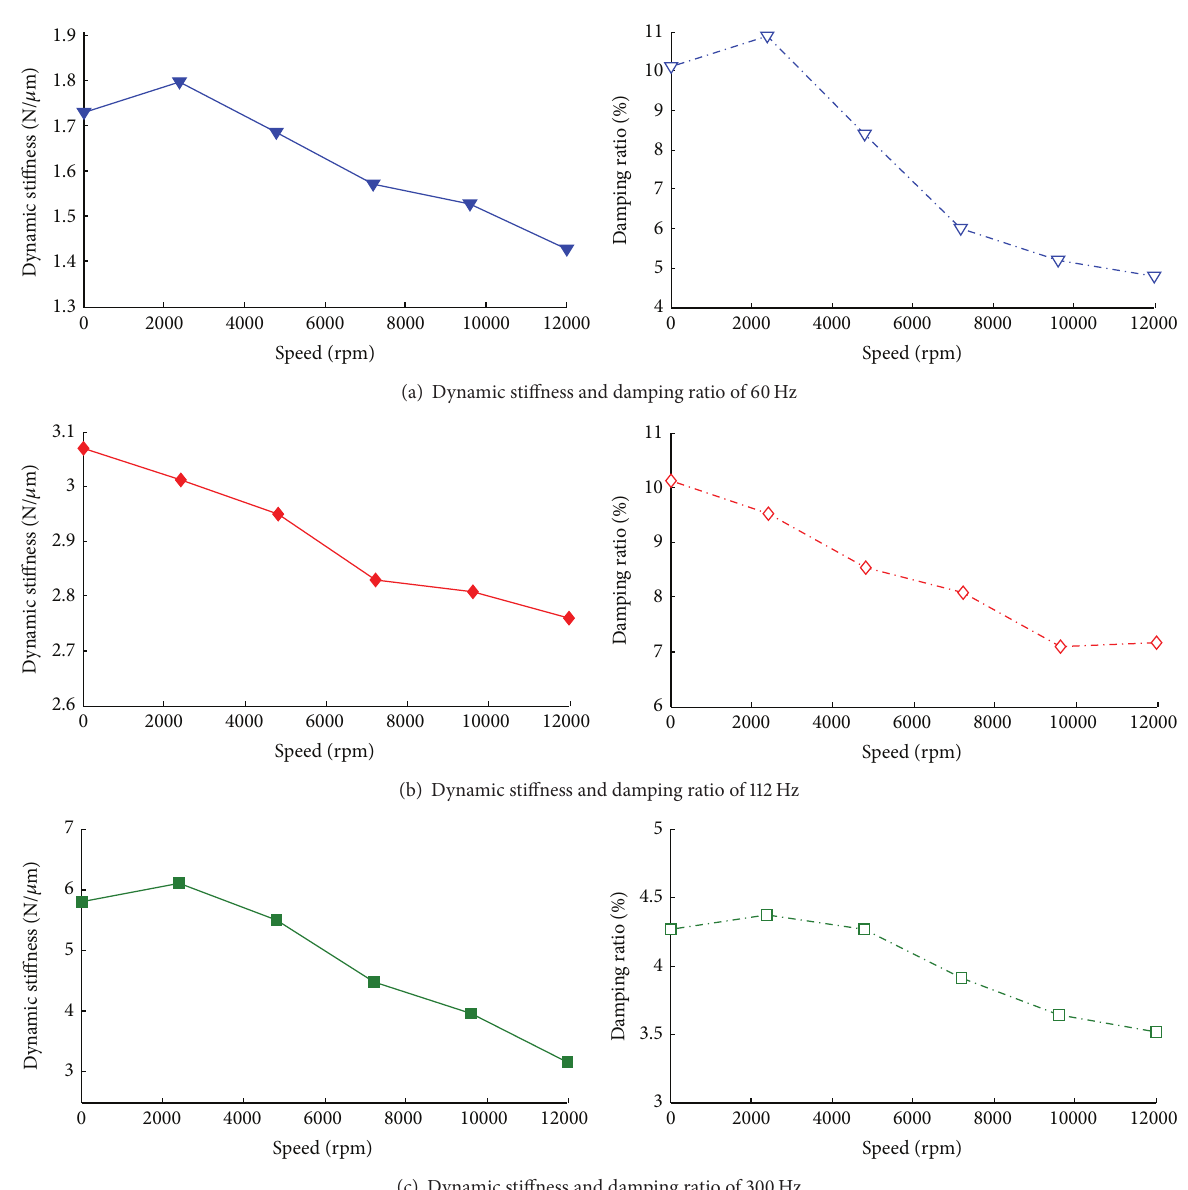
(c) Dynamic stiffness and damping ratio of 300Hz Figure 15: Dynamic stiffness and damping ration of the first three orders resonance at different